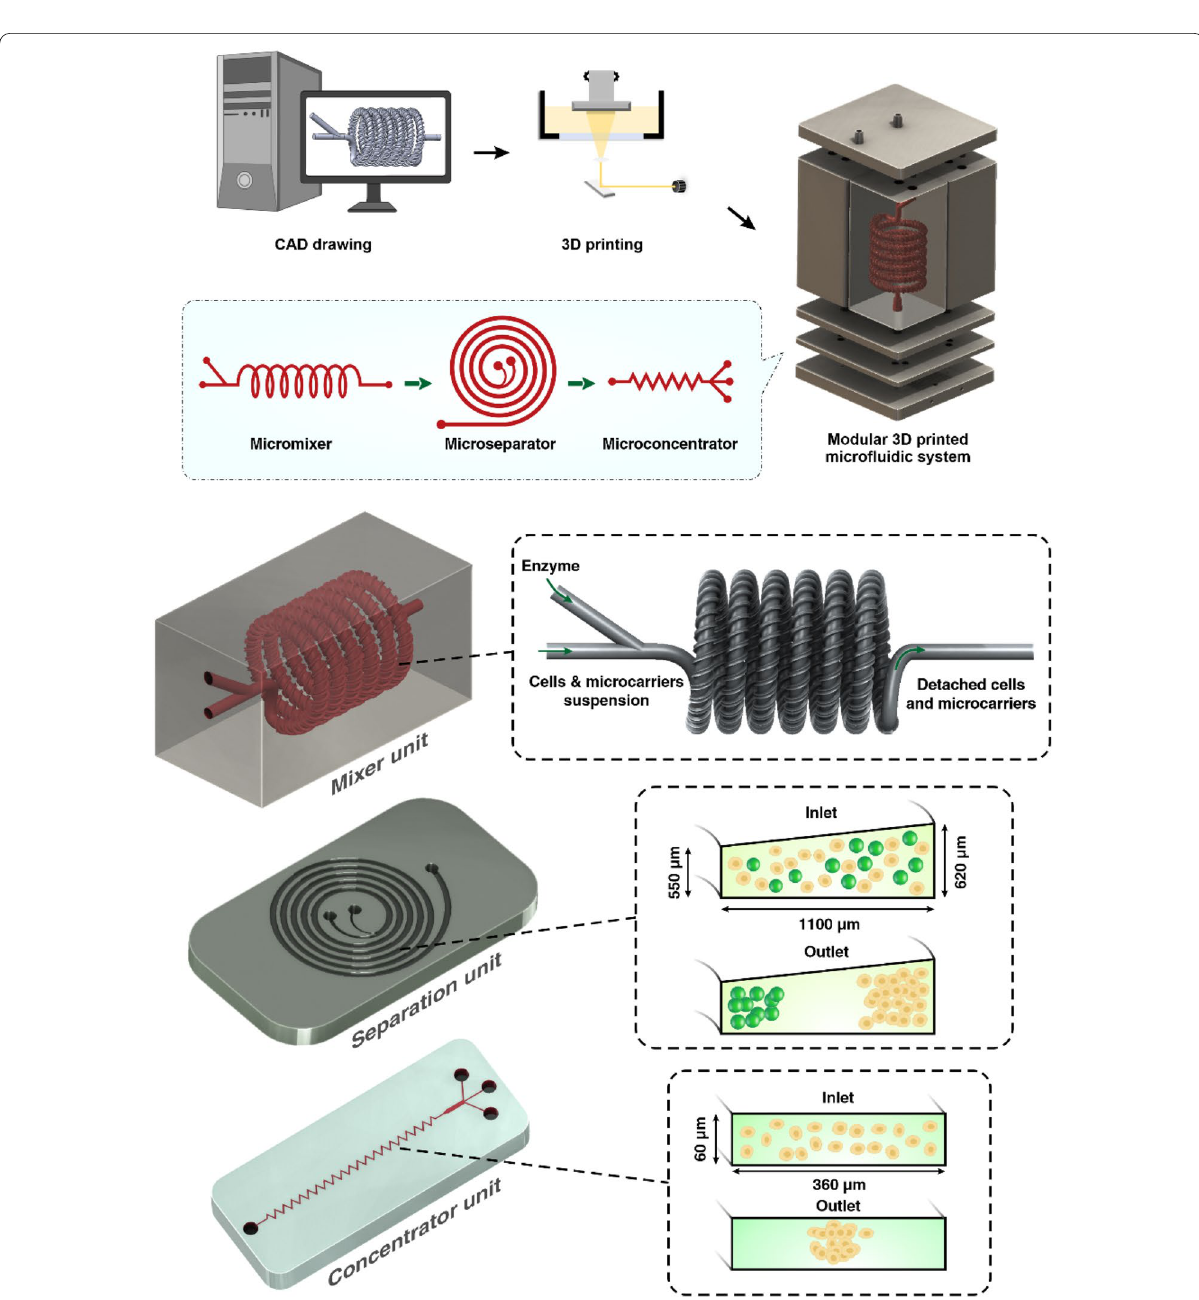
Fig. 1 Schematic representation of the modular microfluidic system. The whole system was built by 3D printing technology. The system comprises two micromixers, a micro separator, and a zig-zag channel connected vertically to detach cells from MCs, separate cells from MCs, and dewater the harvested cells. The adherent cells on MCs were detached from MCs through enzymatic treatment and gentle mechanical force inside of mixer channels. Cells and MCs were then collected separately from spiral outlets and concentrated using the zig-zag concentrator unit. The dimension of the micromixer is shown in Additional file 1: Fig.